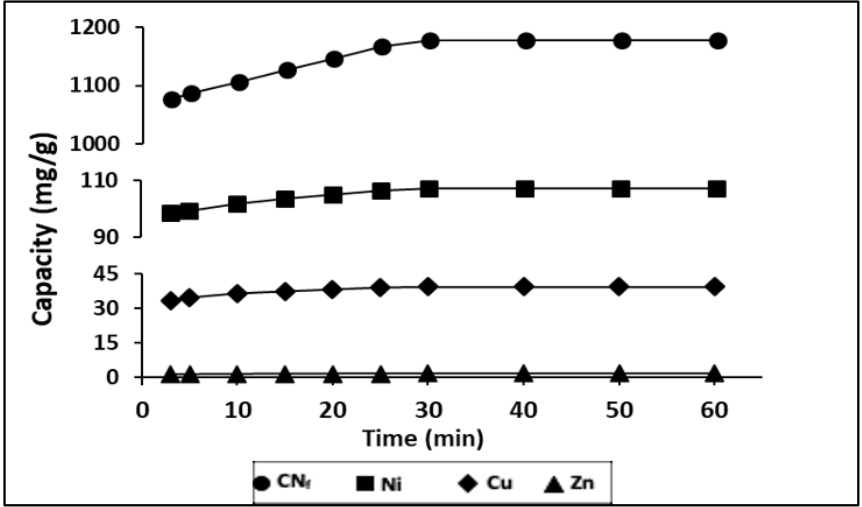
Figure 3. Influence of contact time in the adsorption capacity of all pollutants studied onto CAB.